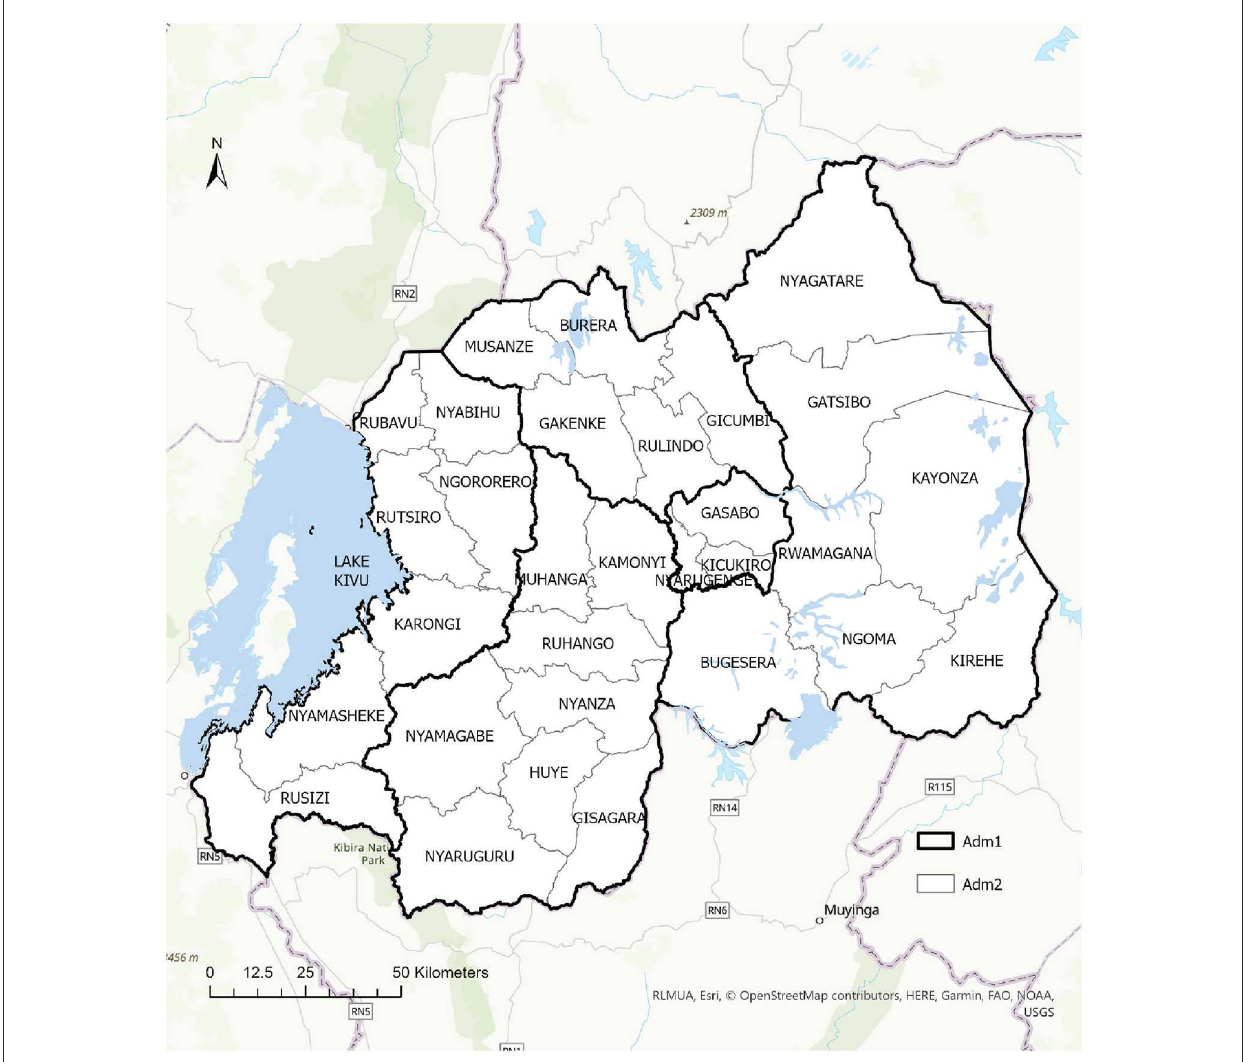
FIGURE1 Map of Rwanda showing the administrative districts and project implementation areas.